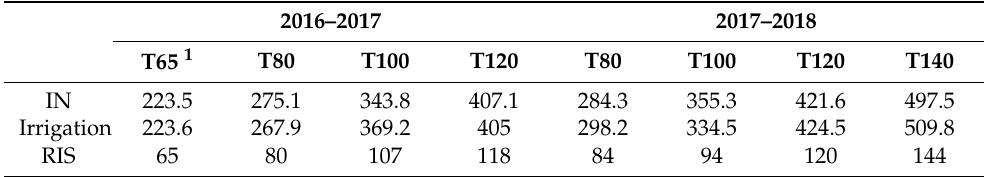
Table 1. Calculated irrigation needs (IN; mm season −1 ), water supplied by irrigation (mm sea- son −1 ), and relative irrigation supply (RIS), in the water treatments applied during the 2016–2017 and 2017–2018 cropping seasons.